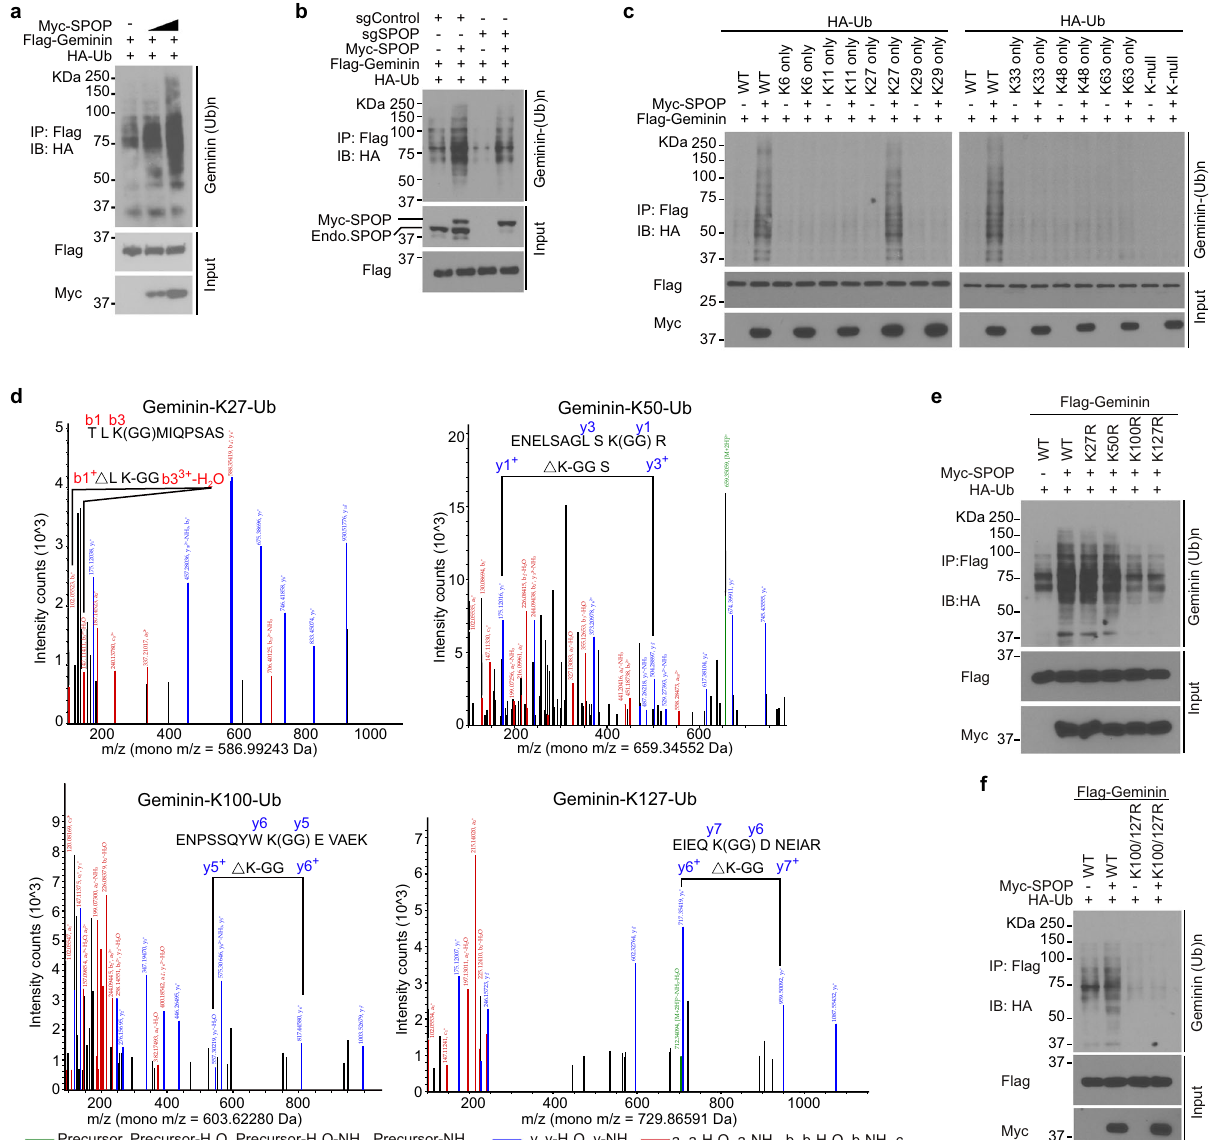
Fig. 2 SPOP promotes ubiquitin lysine 27-linked poly-ubiquitination of lysine 100 and 127 in Geminin. a 293T cells were transfected with increased Myc-SPOP WT in combination with Flag-Geminin and HA-Ub and harvested for IP and WB. b Control or SPOP knockout 293T cells were transfected with the indicated plasmids and harvested for IP and WB. c 293T cells transfected with plasmids for HA-tagged WT or mutated Ub in combination with other indicated constructs and harvested for IP and WB. d Mass spectrometry analysis reveals Geminin ubiquitination at lysine residues 27, 50, 100, and 127. e , f 293T cells were transfected with Flag-tagged WT or mutated Geminin in combination with other constructs and harvested for IP and WB. Source data are provided in this paper or Mendeley database (10.17632/8n7xt5rkhc.1). Similar results for ( a ), ( b ), ( c ), ( e ), and ( f ) panels were obtained in two independent